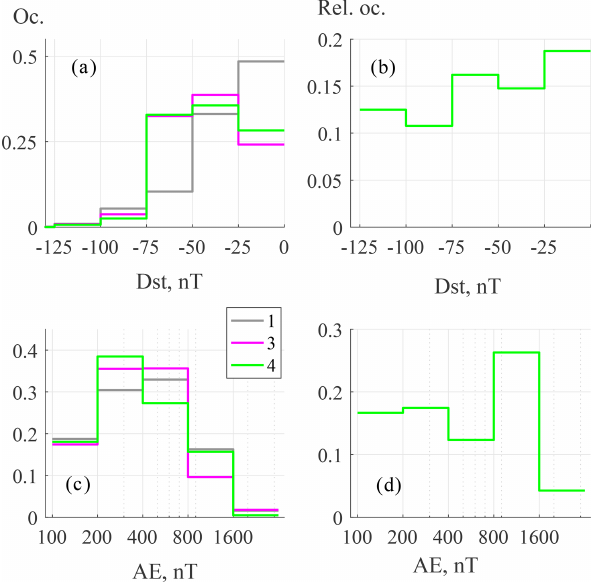
Figure 13. Left panels show activity index distributions for groups 1, 3 and 4: Dst (a) and AE (c) . Right panels show the same for group 4 relative occurrence: Dst (b) and AE (d) .